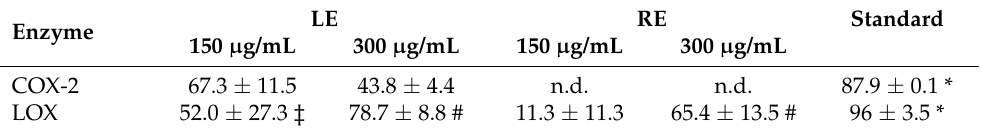
Table 4. In vitro inhibition of LE and RE on cyclooxygenase (COX-2) and lipoxygenase (LOX) enzymatic